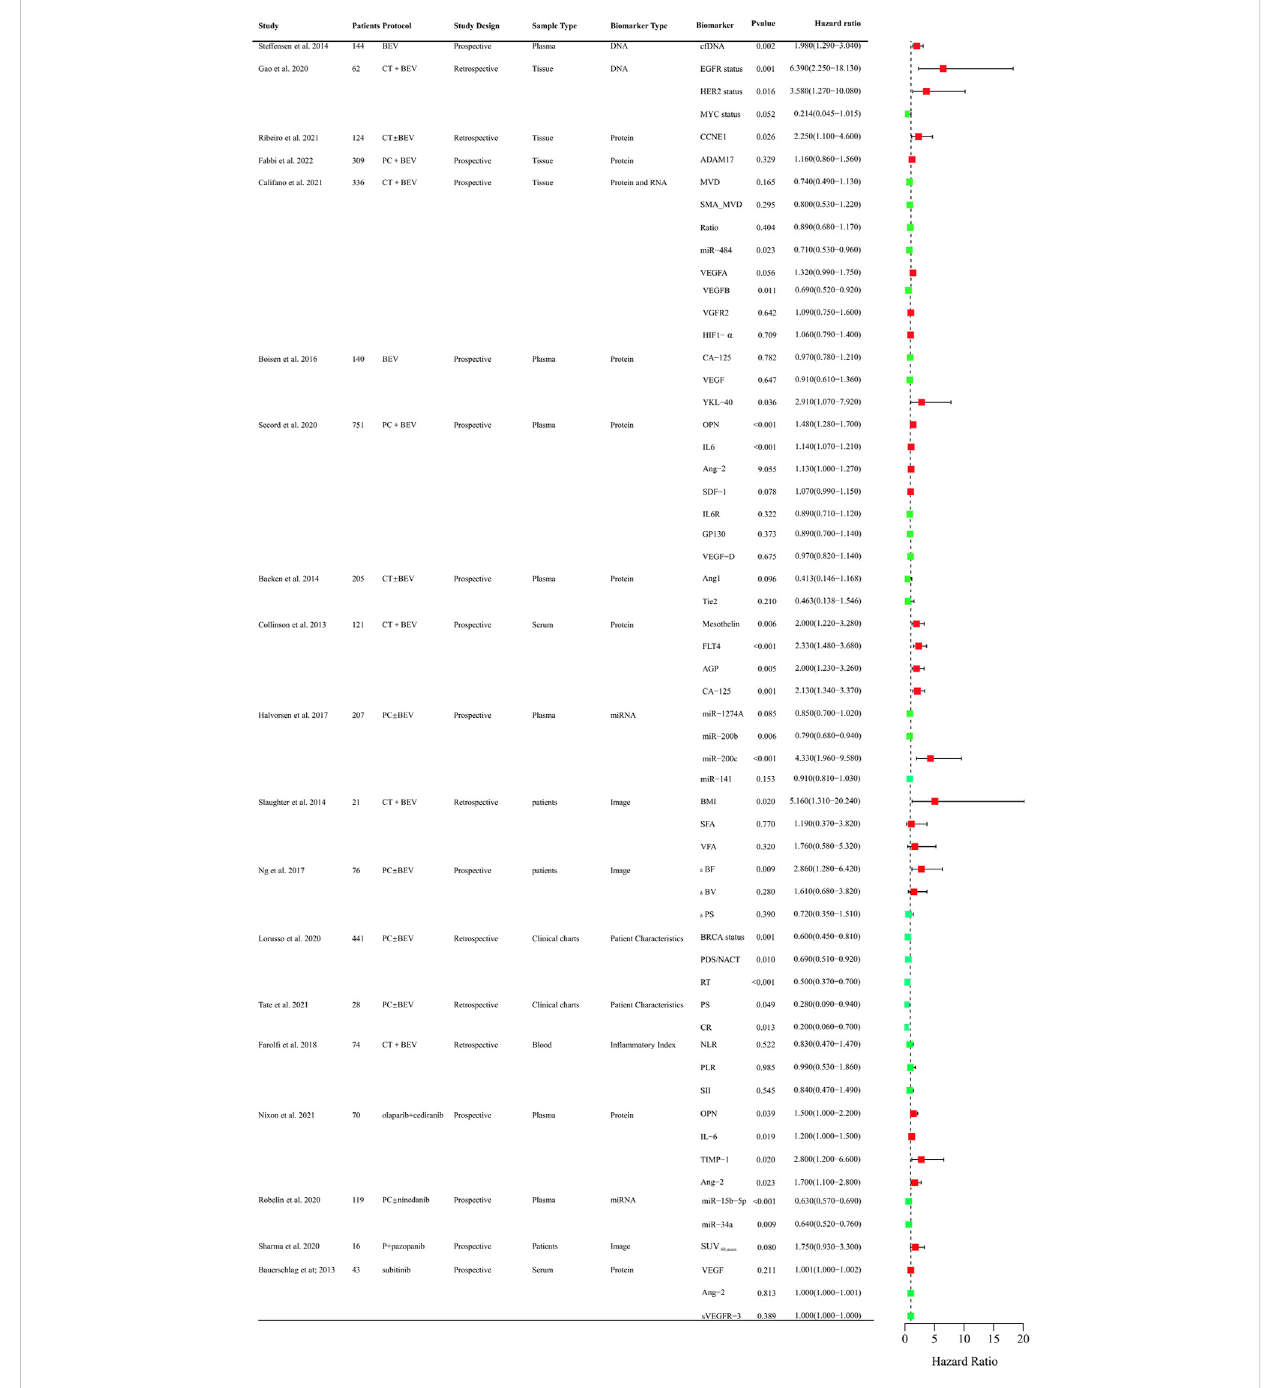
FIGURE 2 Clinical trials assessing biomarkers in relation to PFS of anti-angiogenic drugs in OC. BEV: Bevacizumab; CT: Chemotherapy; PC:TAXOL and CBP; DNA, Deoxyribonucleic Acid; RNA, Ribonucleic Acid; cfDNA, cell-free DNA; EGFR, Epidermal Growth Factor Receptor; HER2, Human Epidermal GrowthFactor Receptor 2; MYC, MYC Proto-Oncogene; CCNE1, Cyclin E1; ADAM17, a disintegrin and metalloprotease 17; MVD, microvessel density; SMA_MVD: Alfa-Smooth Muscle Actin + microvessel density; Ratio, α -SMA + MVD/MVD ratio; miRNA, microRNA; VEGFA, vascular endothelial growth factor A; VEGFB, vascular endothelial growth factor B; HIF-a, Hypoxia-Inducible Factor 1-alpha; OPN, osteopontin; SDF-1, stromal cell – derived factor-1;IL6R,IL6receptor;FLT4,fms-liketyrosinekinase-4;AGP,a1-acidglycoprotein;BMI,bodymassindex;VFA,visceralfatarea;SFA,subcutaneous fat area; Δ BF, change of Tumor Blood Flow; Δ BV, change of Tumor Blood Volume; Δ PS, change of Vessel Permeability Surface Product; PDS/NACT, Primary Debulking Surgery/Neoadjuvant chemotherapy; RT, Residual Tumor; PS, Performance Status; CR, Completeness of resection; NLR, neutrophil- to-lymphocyte ratio; PLR, platelet-to-lymphocyte ratio; SII, systemic immune in fl ammation